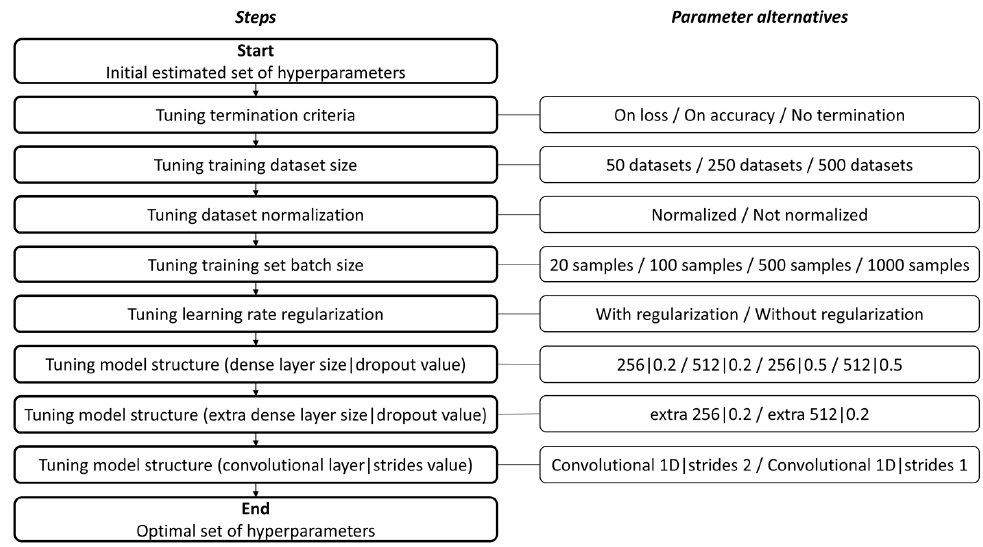
Figure 3. Example of a data sample, showing the normalized hourly measurements during a 24 h period (one day) for each WDN sensor: ( a ) numeric values in tabular form; and ( b ) visual representation using a color scale.